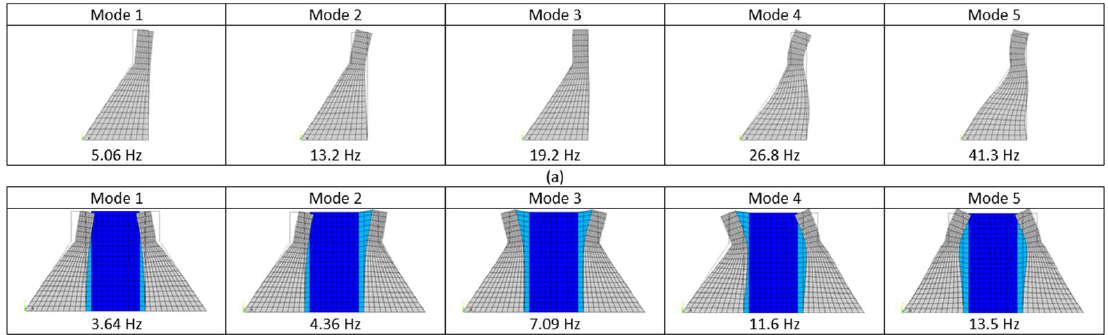
Figure 7. Vibration modes of the lock: (a) uncoupled structural system (left structure) and (b) coupled fluid-structure system.